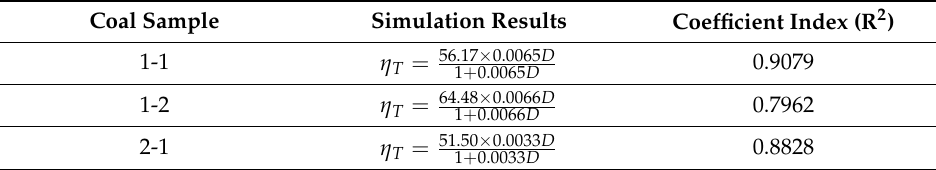
Table 8. Simulated results for critical pore